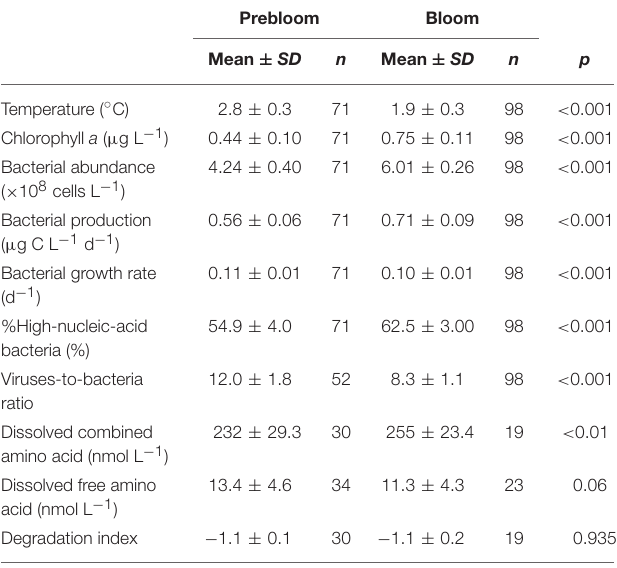
TABLE 1 | Mean values of hydrographical, microbial, and dissolved amino acid parameters determined in the upper layer during prebloom and bloom periods.